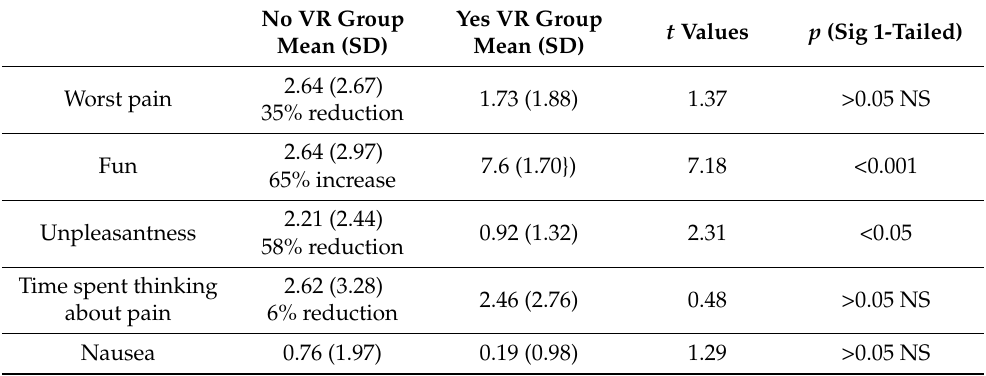
Table 4. (Ages 12–17). Pain, fun, and nausea mean levels in the experimental and control